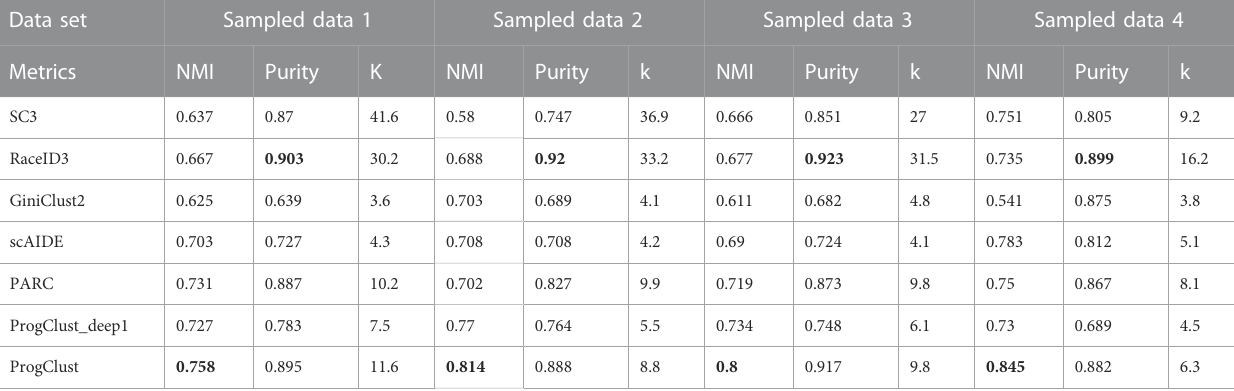
TABLE 3 Comparison of the performance of different clustering methods on PBMC sampled data: average NMI, Purity and k over 10 independent runs. Data